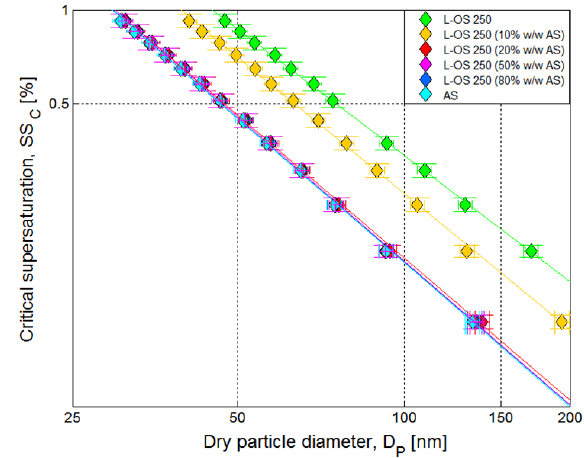
Figure 5. Critical supersaturation (SS c ) as function of dry particle diameter for the six investigated particle compositions. The curves follow the Köhler slope of approximately − 3/2 for L-OS 250/AS compositions with ≥ 20% AS. The curves for pure L-OS 250 and L-OS 250 with 10% AS have a slope of approximately − 1.4. Er- ror bars represent the uncertainty on the particle dry size diameter ( x axis) and SS c ( y axis). Note that the data are plotted in log–log